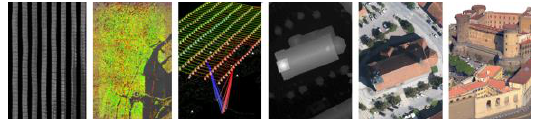
Fig. 2: UltraMap offers the processing chain for UltraCam images. Results are image orientation (AT), interactive and automated measurements, surface models, ortho images and three-dimensional object